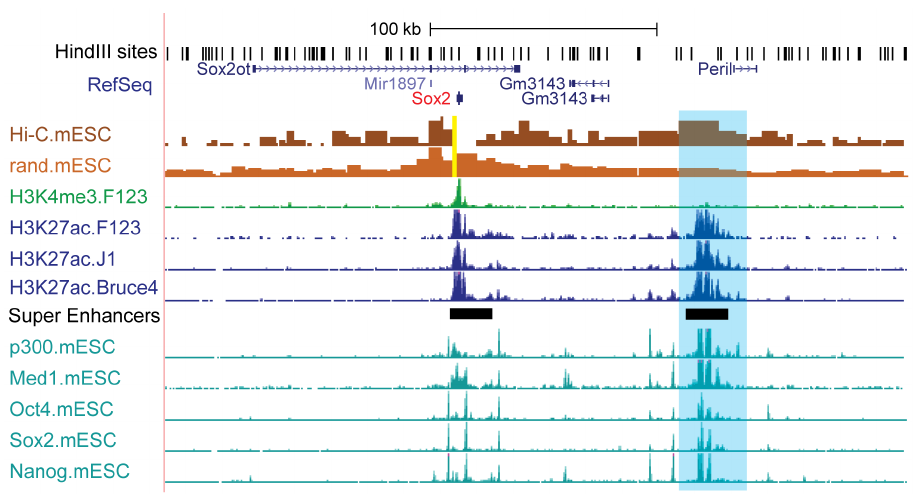
Figure 2. Characterization of the distal Sox2 super-enhancer. In a genome-browser snapshot, the top Hi-C track is a bar graph showing the Hi-C read number in mouse ESCs using Sox2 as the anchor (highlighted in yellow). Each bar represents one HindIII fragment between two HindIII cutting sites. The bar height represents the Hi-C read count from the anchor to the HindIII fragment. The 2 nd Hi-C track plots the expected value for every HindIII fragment. Therefore the blue highlighted region is a significant looping interaction from the Sox2 promoter to Sox2-SE distal after comparing the top two tracks. The ChIP-seq tracks show the locations of different histone marks or protein factors in mouse ESC lines. The super-enhancer track shows the locations of two super-enhancers in mESCs identified by Hnisz et al.